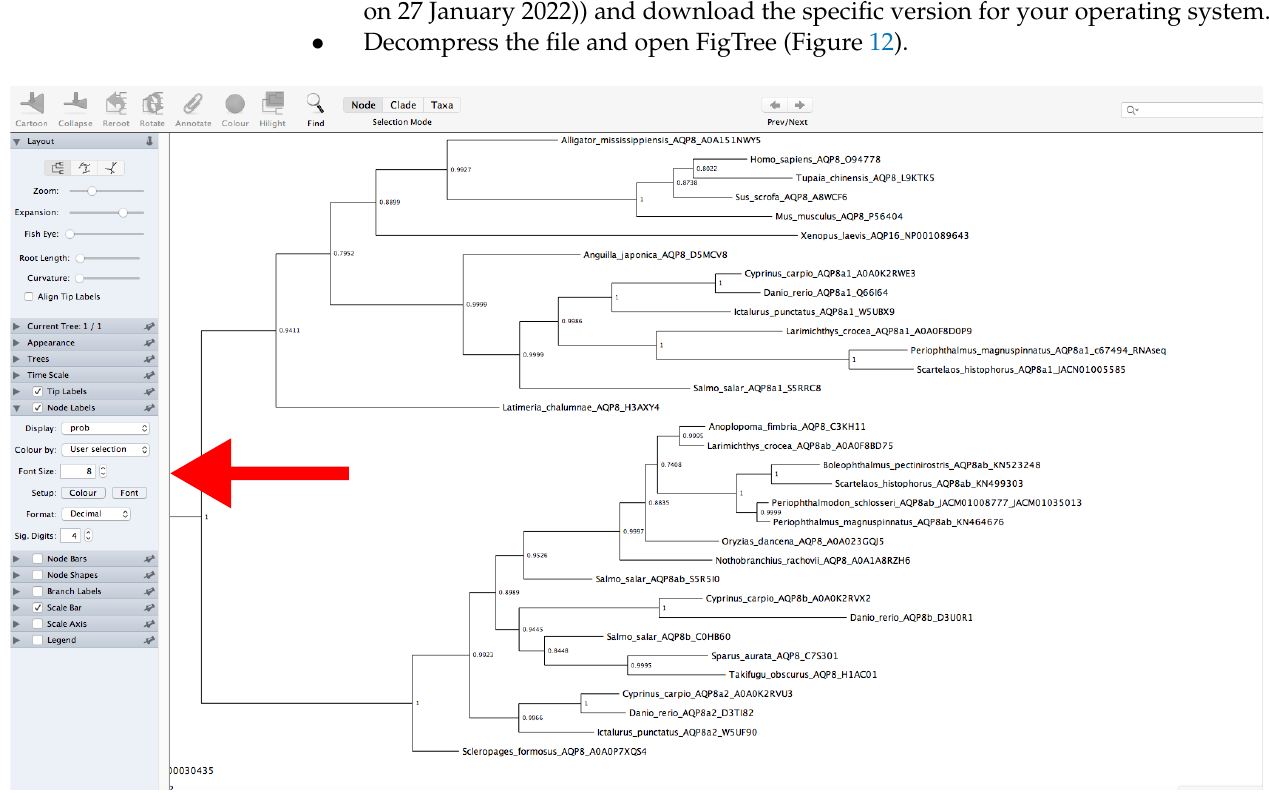
Figure 12. FigTree program. The red arrow indicates the Node Label panel.